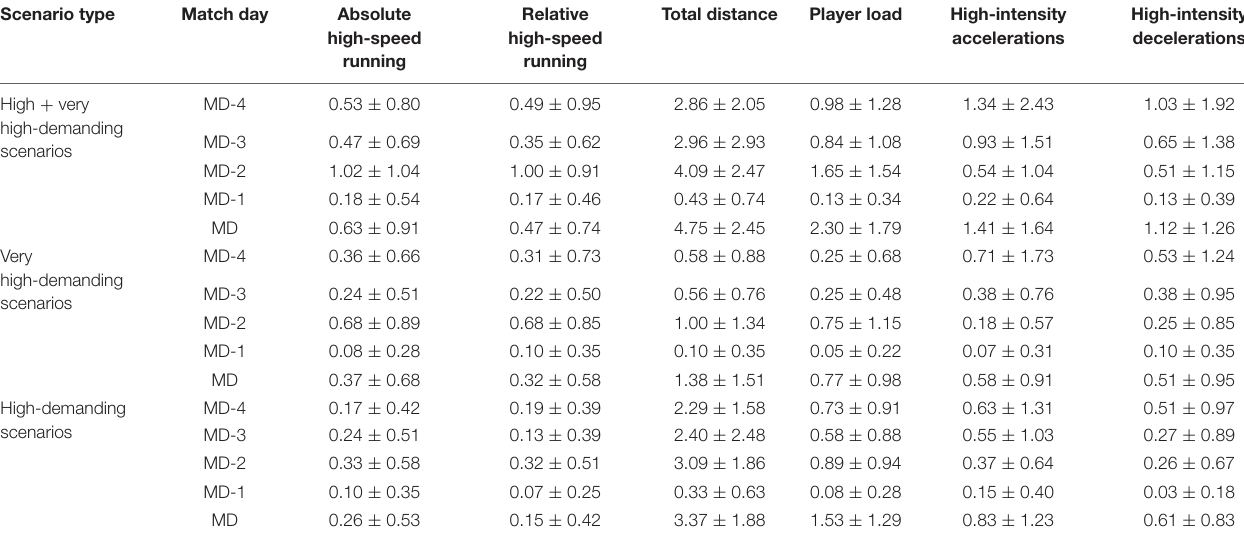
TABLE 2 | Number (mean ± standard deviation) of scenarios for each type, match day, and variable analyzed.